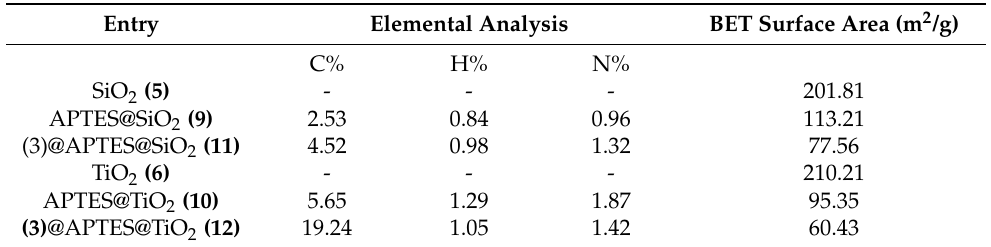
Table 2. BET analysis and CHN data of the SiO 2 (5) , APTES@SiO 2 (9) , (3) @APTES@SiO 2 (11)